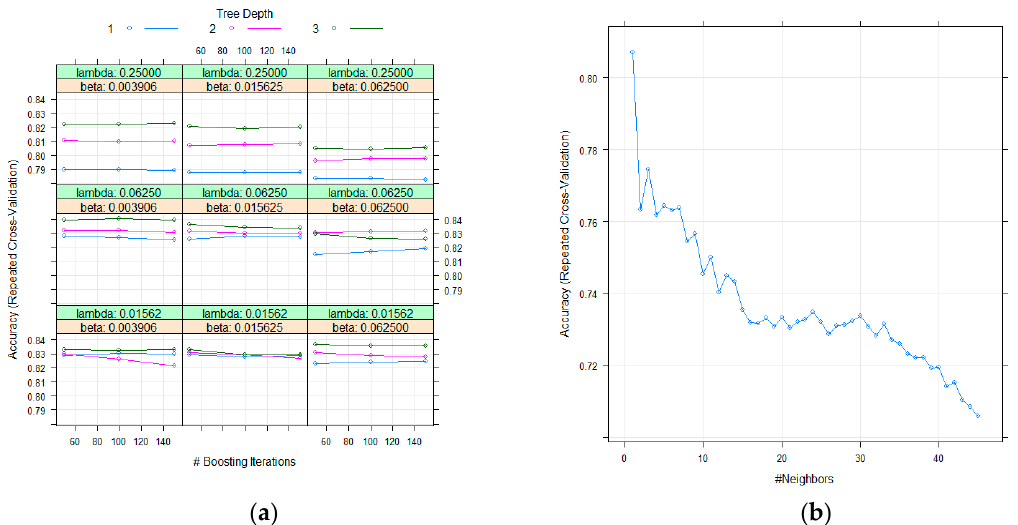
Figure 8. Optimization results of the deep boosting ( a ) and k-nearest neighbors algorithm ( b ).